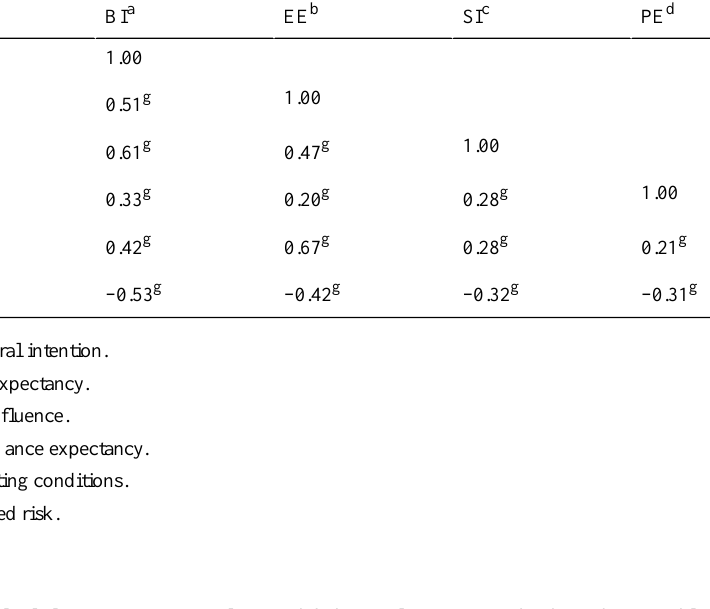
Table 8. Multiple linear regression analysis with behavioral intention as the dependent